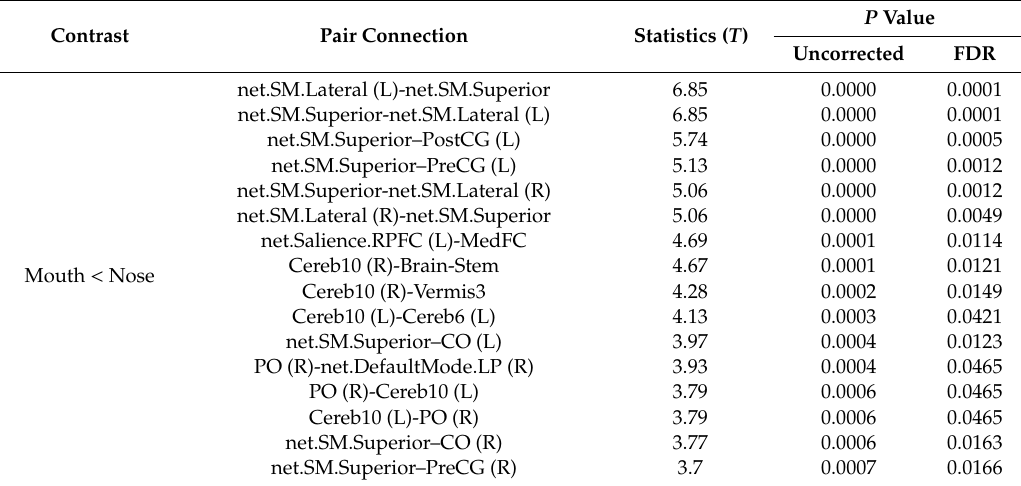
Table 3. Mouth < Nose contrast ROI connections with threshold ROI-to-ROI connections by intensity at a 0.05 one-sided (positive) FDR- P value and threshold seed ROIs at a 0.05 uncorrected P value.